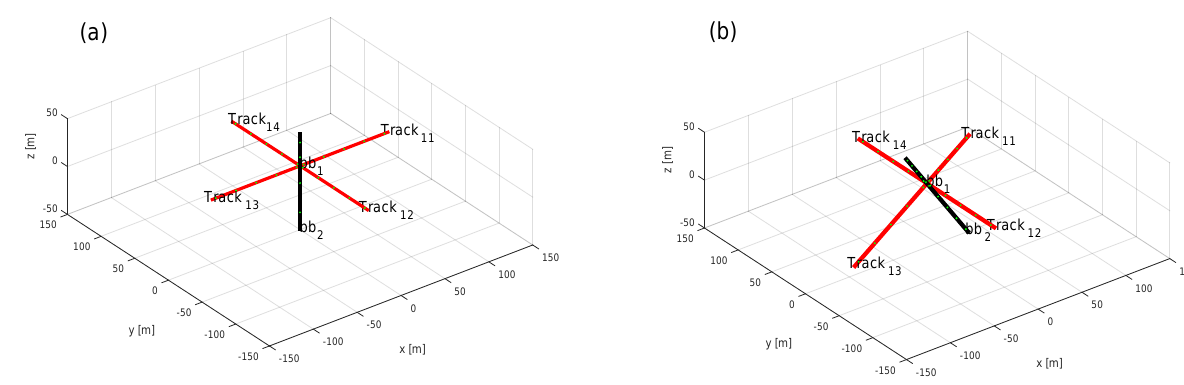
Figure 1. Well configuration for case 1 ( a ; vertical well with four horizontal laterals) and for case 2 ( b ; deviated well with four laterals).